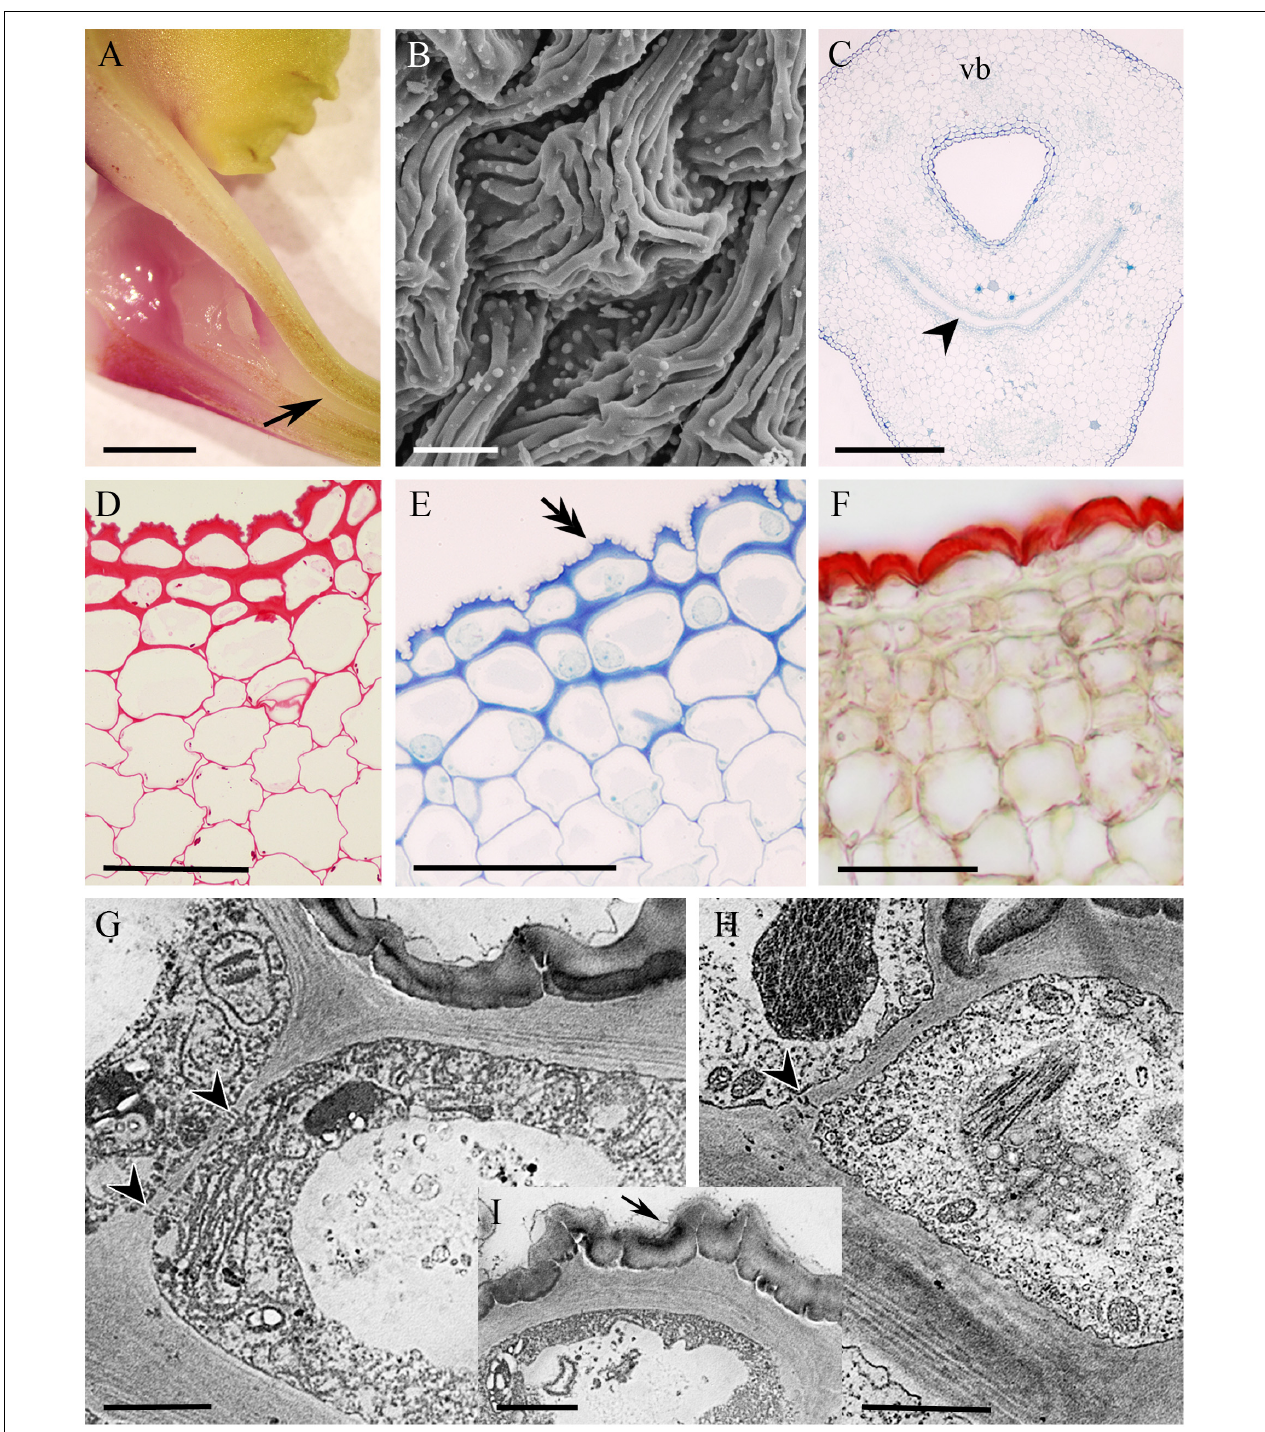
FIGURE 11 | Epidendrum xanthoianthinum . (A) Longitudinal section of flower, the cuniculus indicated by arrow. (B) Ridged surface of blistered cuticle of epidermal cells. (C) Transverse section of ovary showing cuniculus and associated tissues, the transmitting tract indicated by arrowhead (MB/AII). (D) PAS reaction stains cell walls and sparse starch grains. (E) Detail of epidermis and subepidermal parenchyma. Note that cellulosic projections of the cell wall (double arrow) penetrate the cuticle (MB/AII). (F) The thick cuticle stains selectively with Sudan III. (G) Parietal cytoplasm of epidermal cell, showing profiles of ER and plastids. Vesicles are present in the vacuole. Surface secretion is visible on the cuticle. (H) Plastids with dense stroma and minute starch grains in epidermal cells. In G,H , plasmodesmata in anticlinal walls are marked with arrowheads. (I) Detail of cell wall penetrating cuticle and secreted surface material (arrow). Scale bars: A = 2 mm; B = 10 µ m; C = 300 µ m; D–F = 50 µ m; G–I = 2 µ m. vb, vascular